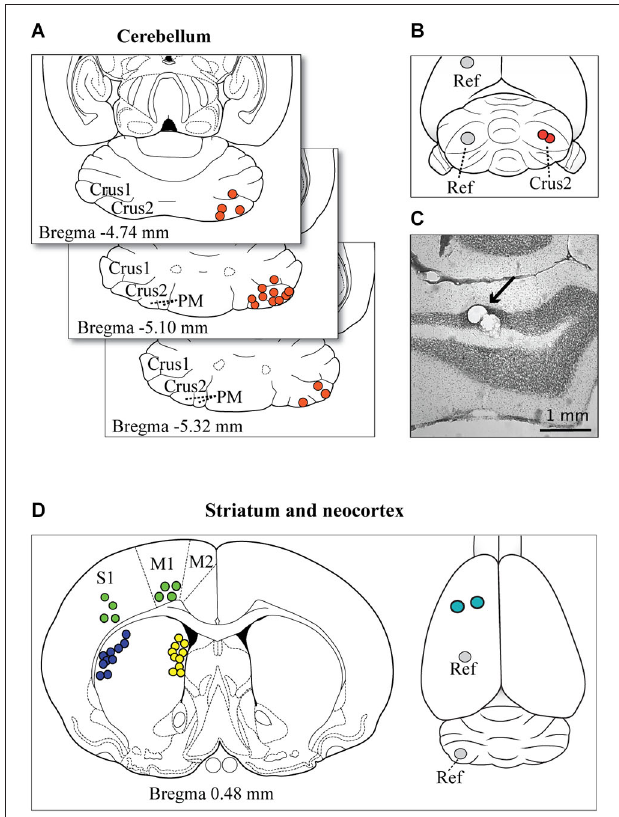
FIGURE 1 | Microelectrode tip localizations and reconstructions . (A) The representative spread of identified electrode tip locations in the cerebellum are shown (filled circles) on horizontal sections taken from the atlas of Paxinos and Watson (1998). (B) Example of the target location of the two insertion points of the microelectrodes on the surface of the exposed cerebellar cortex (red circles). Cerebellar recordings were obtained on the right side of the brain, and the reference wire (Ref) was positioned in the opposite hemisphere in either the left cerebellar cortex or more rostrally in the parietal cortex. (C) A photomicrograph shows the location of microelectrode tip lesions in the granule cell layer of Crus2 (arrow). Most electrode tips were located in the granule cell layer or within close proximity. (D) The panel at left shows a representative spread of the location, based on atlas reconstructions, of identified microelectrode tips in the striatum (dorsolateral, blue circles; medial, yellow circles) and neocortex (green circles). The panel at right shows the optional locations of the reference wires (Ref) and the insertion points for cortical and striatal electrodes (teal